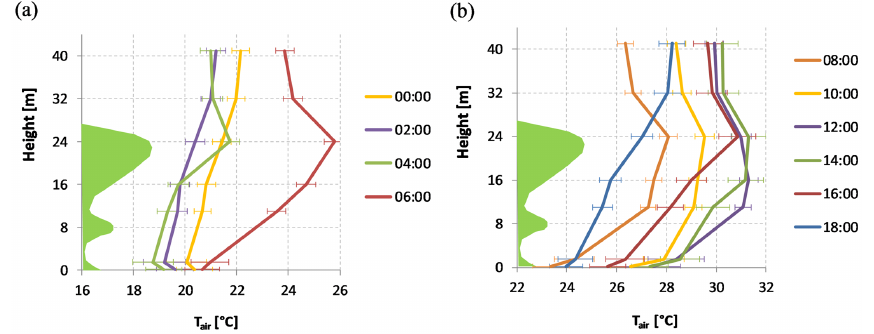
Figure 2. Diurnal evolution of vertical profile of air temperature. (a) From 0:00 to 06:00LT; (b) from 08:00 to 18:00LT. The green shaded area represents the vertical distribution of the leaf area density expressed as m 2